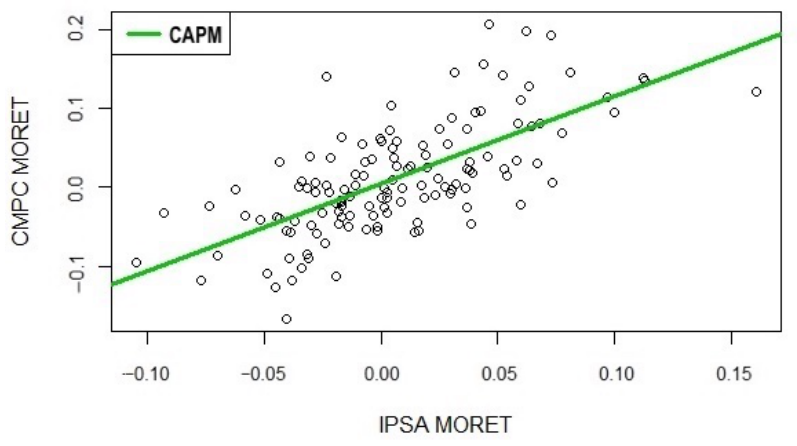
Figure 6. Scatter plot of monthly returns for the IPSA and CMPC with fitted CAPM